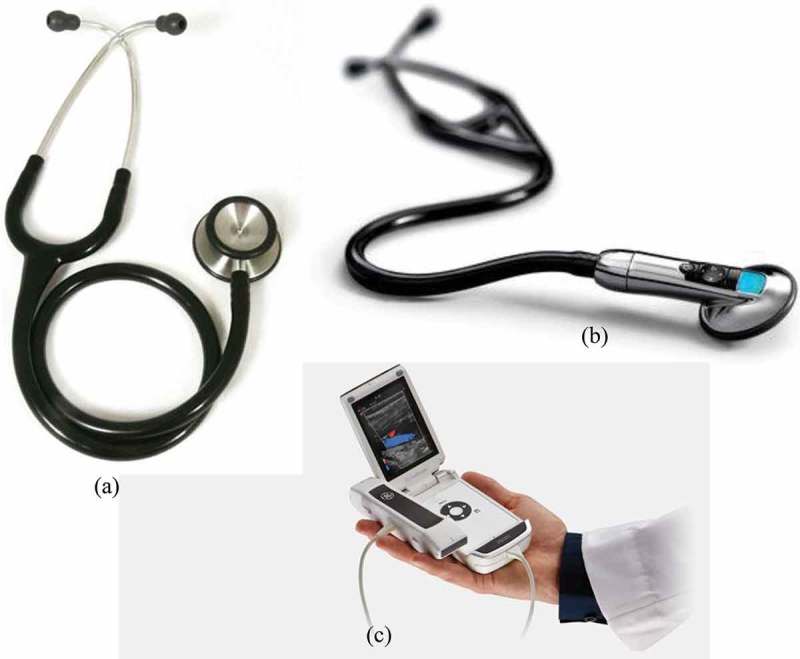
The devices used in this study. (a) A standard mechanical/acoustic stethoscope. (b) A digital/electronic stethoscope. (c) A hand-held echocardiogram device. Images reproduced under Creative Commons License. Property of Medisave.co.uk, 3M Littmann, and GE Healthcare.